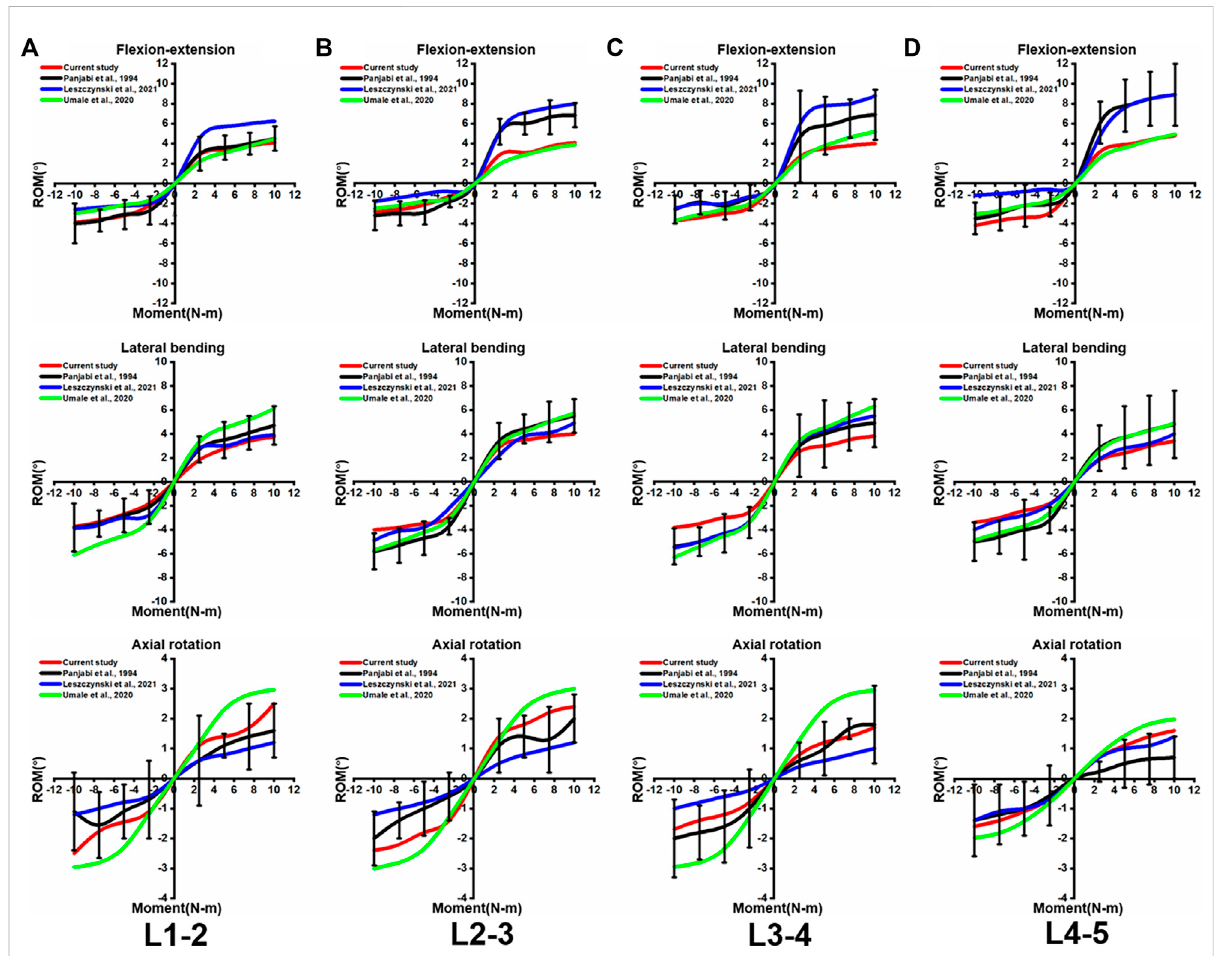
FIGURE 4 Comparison of theintersegmental ROM betweenthe presentintact model and theoutcomes of previous publicationsunder pure moments of 2.5N-m,5N-m,7.5n-m, and 10N-m conditions at (A) L1-2, (B) L2-3, (C) L3-4, and (D) L4-5. Error bars represent standard